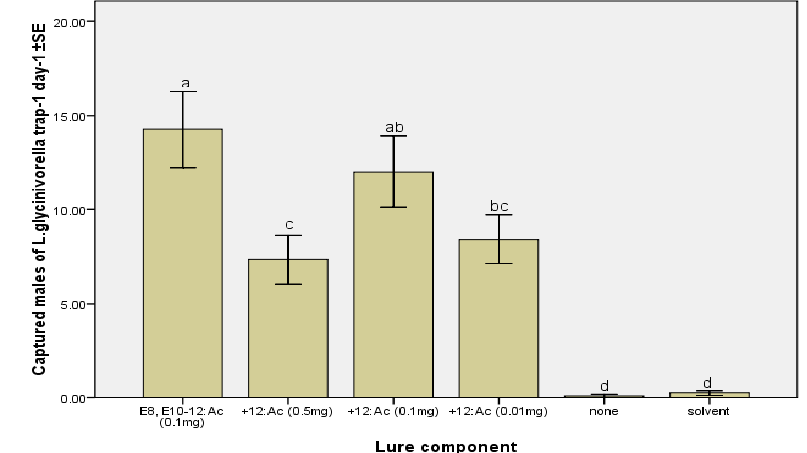
Figure 3. Mean (±SE) numbers of L. glycinivorella males captured per trap per day in traps baited with the binary blend of EE- 8,10-12:Ac and 12:Ac in different doses compared with control groups in rubber septa. The field test was conducted in a soybean field in Harbin, China from 7 August to 17 August 2011. Bars with different letters are significantly different (ANOVA and Tukey’s HSD, p <